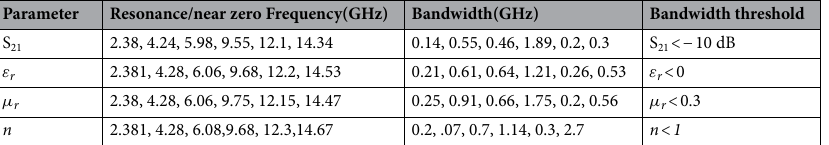
Table 4. Extracted parameter with important properties of the unit cell.